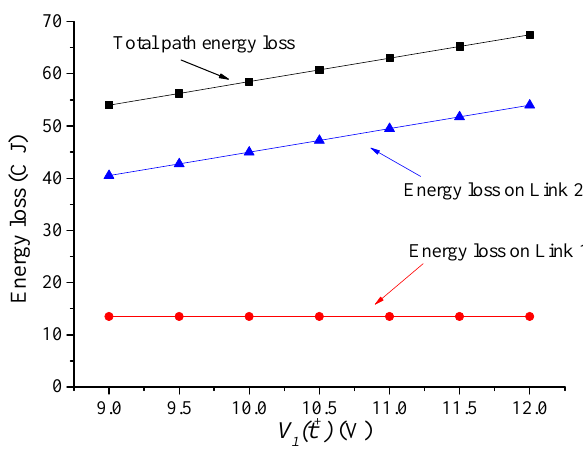
Figure 5. Path and link energy losses as functions of V 1 ( t + )